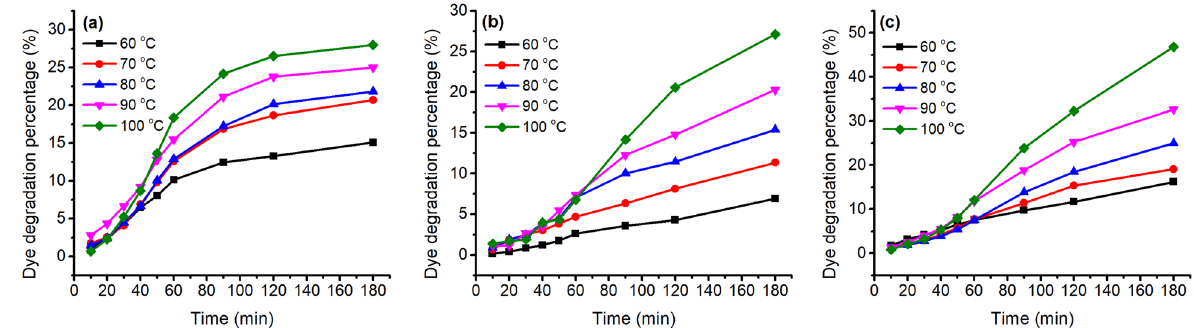
Figure 5. Thermostability of 80 mg L −1 of ( a ) MR, ( b ) GB, and ( c ) GY dyes in deionized water at pH 4 and 60–100 °C.